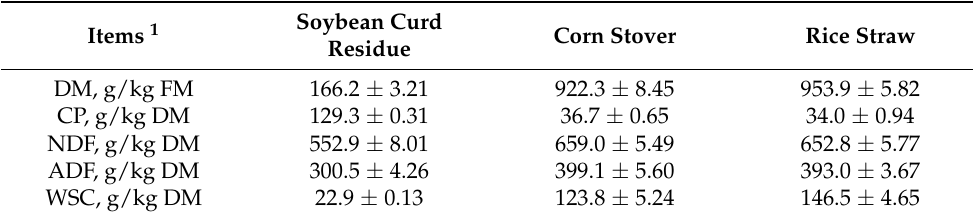
Table 1. Chemical composition of soybean curd residue, corn stover, and rice straw (Mean ± SD, n = 3). Soybean Curd Corn Items 1 Residue